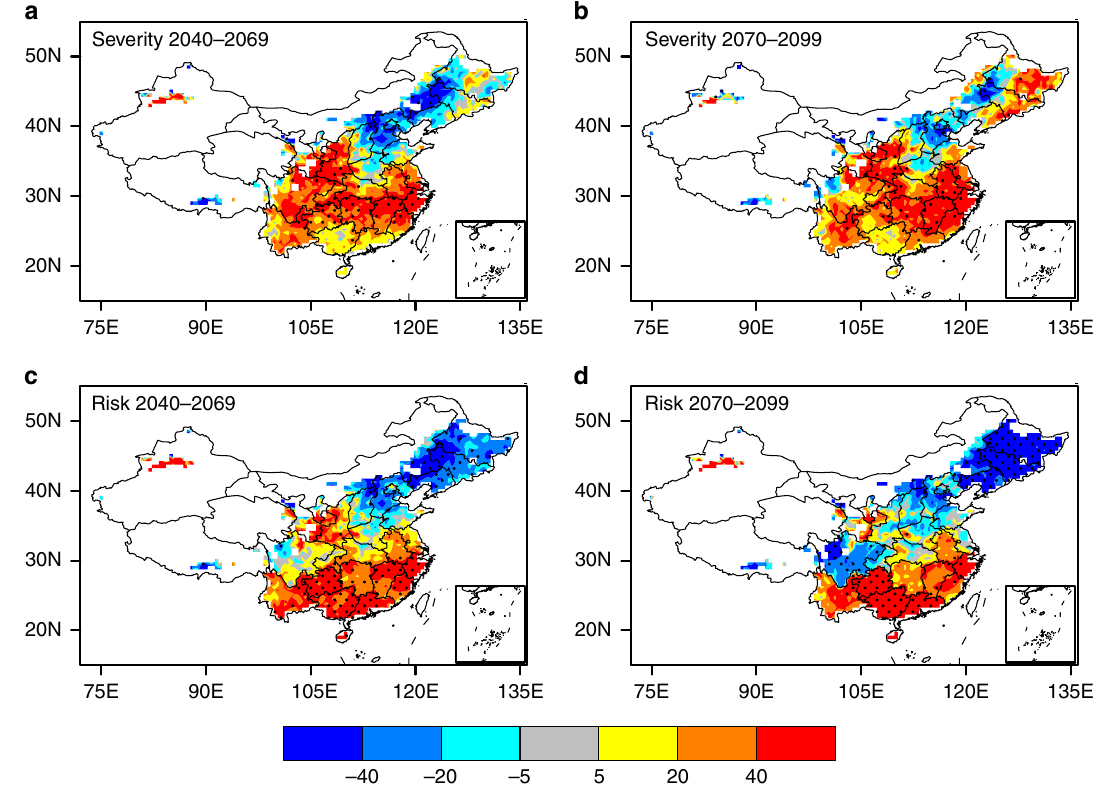
Fig. 3 Future changes in fl ash drought severity and risk over China. Percentage changes in multimodel ensemble mean severity of fl ash drought from 1970 – 1999 to a 2040 – 2069 and b 2070 – 2099 simulated by multiple land surface models (i.e., CLM4.5, VIC, NoahMP) driven by multiple CMIP5 models under the RCP4.5 emission scenario (29 simulations in total, see Supplementary Table 1 for details). c , d , as for a and b , but for the changes in fl ash drought risk. Here, the risk is de fi ned as exposure by multiplying population with drought duration (days*persons). The population scenarios for Shared Socioeconomic Pathways with medium challenges to mitigation and adaptation (SSP2) provided by National Climate Center at China Meteorological Administration was used for future projection. Regions with risk values <0.1 million days*persons per year were masked. Stippling denotes the regions where over 80% of the models agree on the sign of changes. All the statistics were calculated during the growing seasons (April – September). Maps were created by using the NCAR Command Language (Version 6.3.0) [Software]. (2016). Boulder, Colorado: UCAR/NCAR/CISL/TDD.